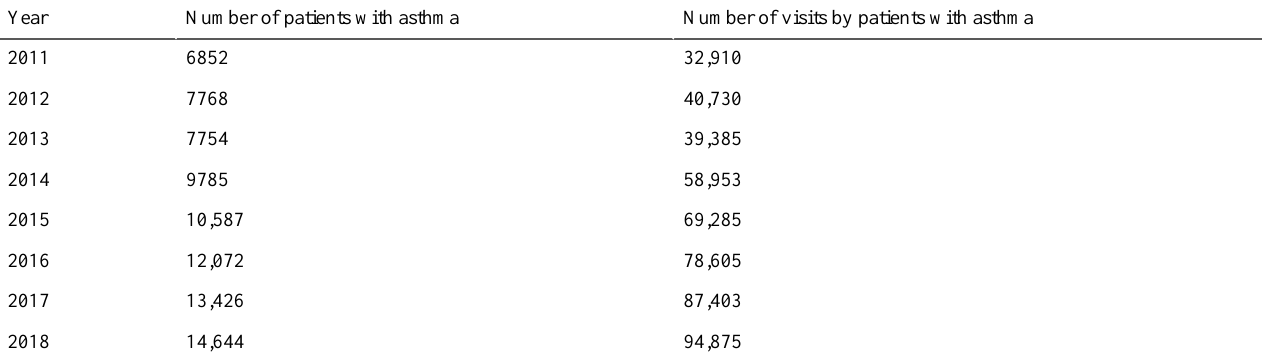
Number of visits by patients with asthmaNumber of patients with